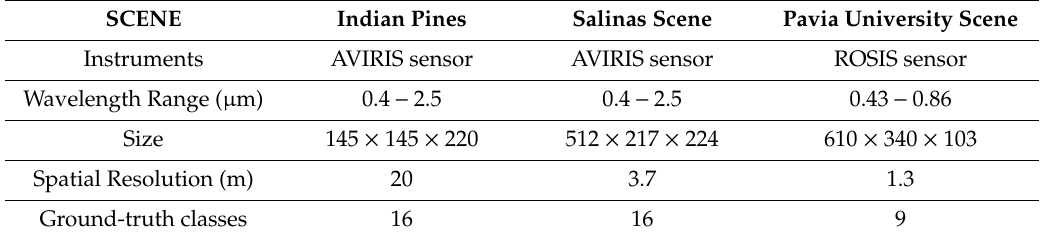
Table 3. Details of the three experimental hyperspectral images.